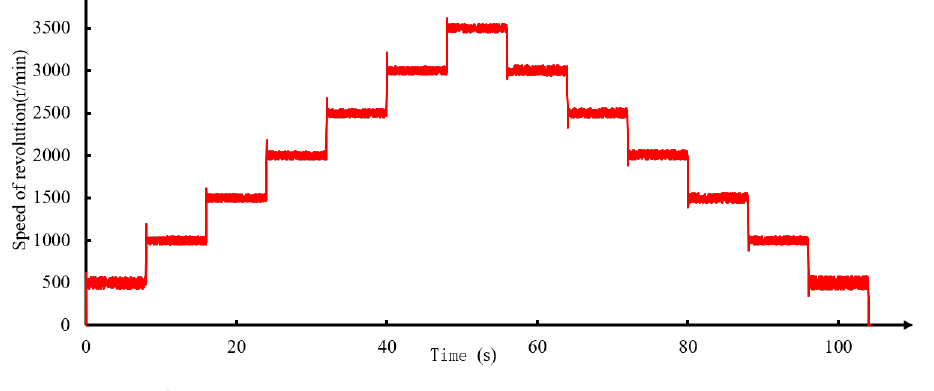
Figure 15. Speed response curve. Table 5. Response test for increasing speed of dc motor of single fertilizer apparatus.